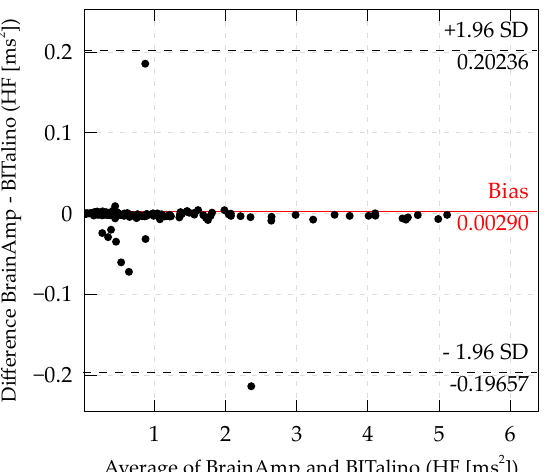
Figure 7. Bland–Altman plot of HF. (Some data points outside the LoA are cutoff to offer a more detailed view of the distribution inside the LoA.)